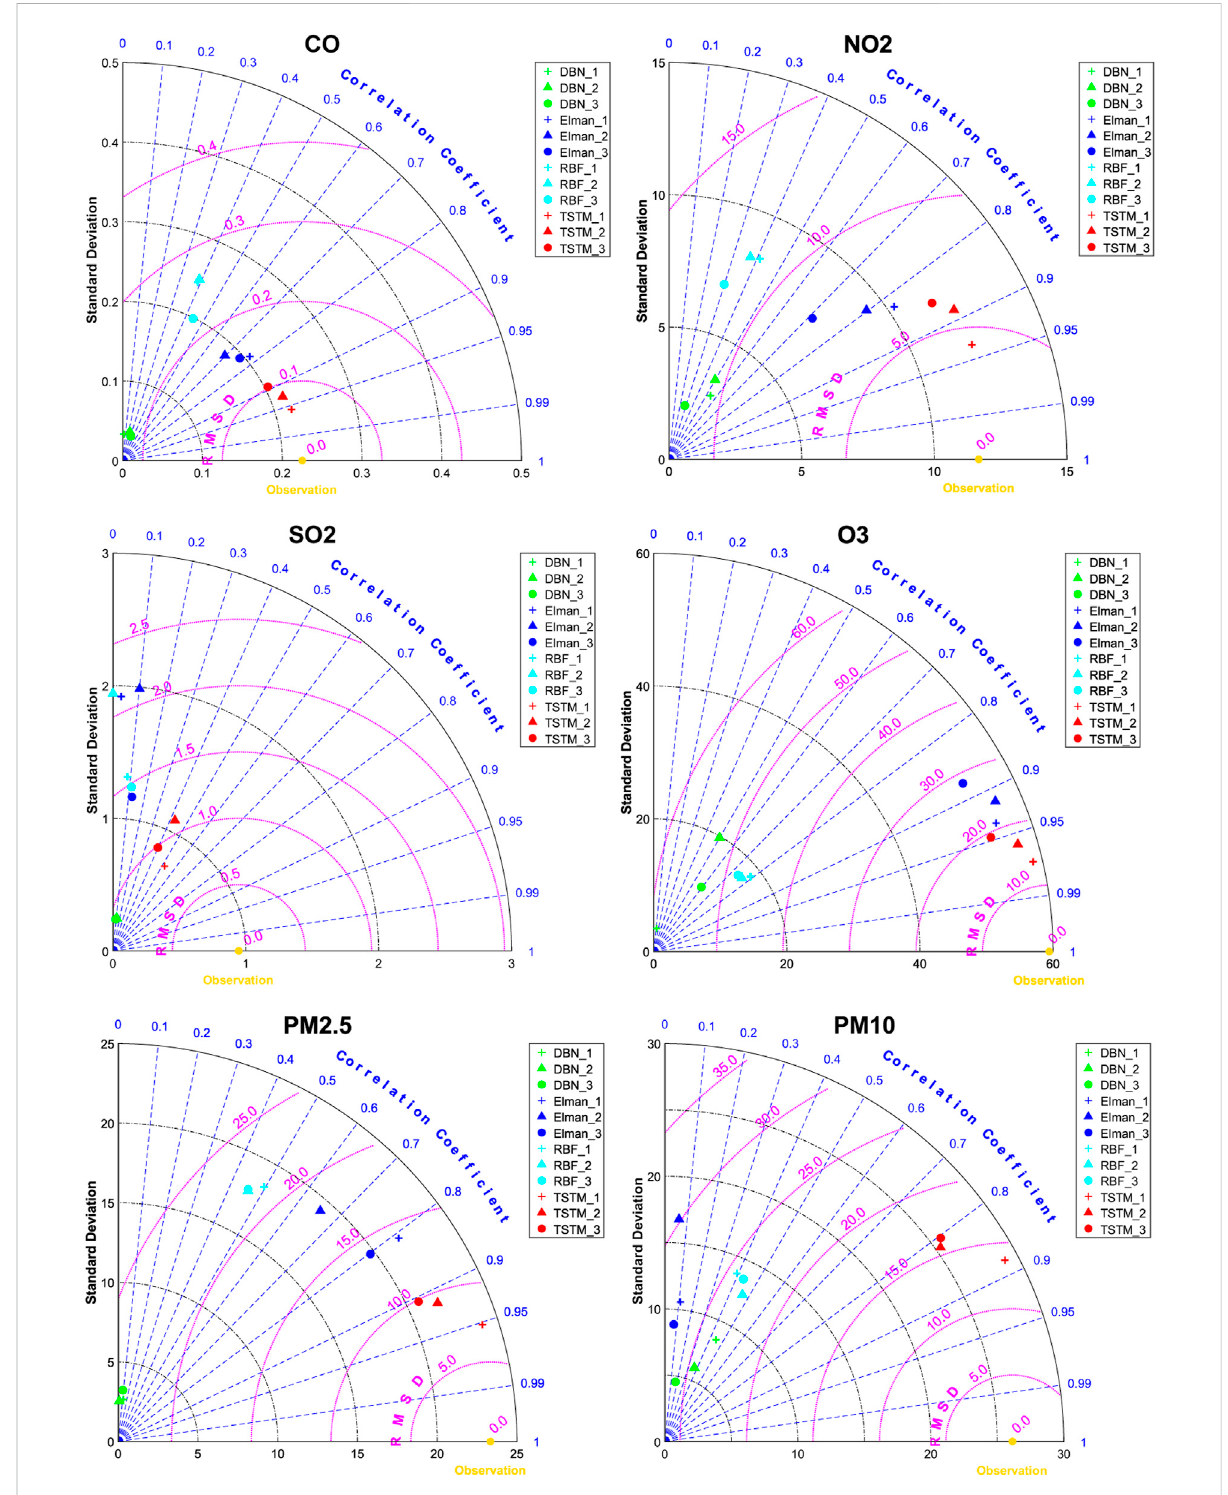
FIGURE 13 The Taylor diagram of pollutant concentration prediction in Beijing (Test